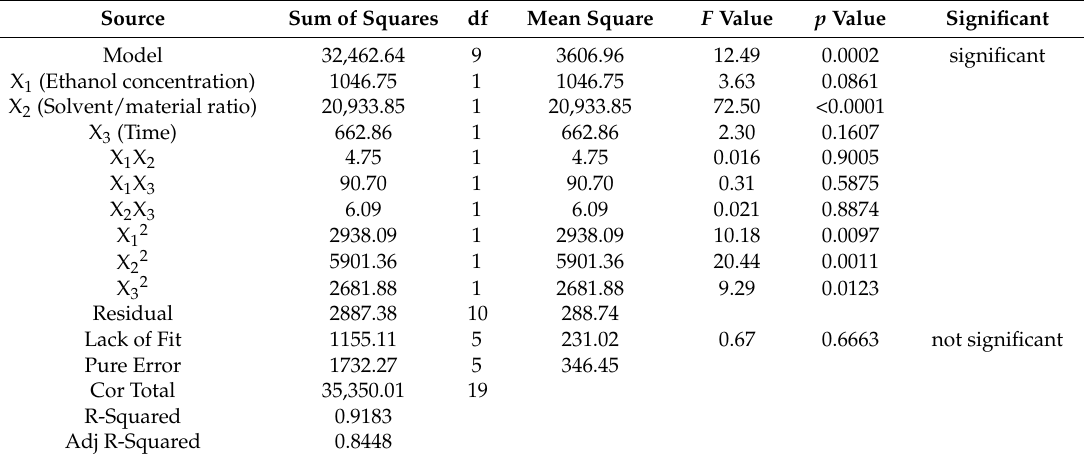
Table 2. ANOVA of the fitted polynomial quadratic